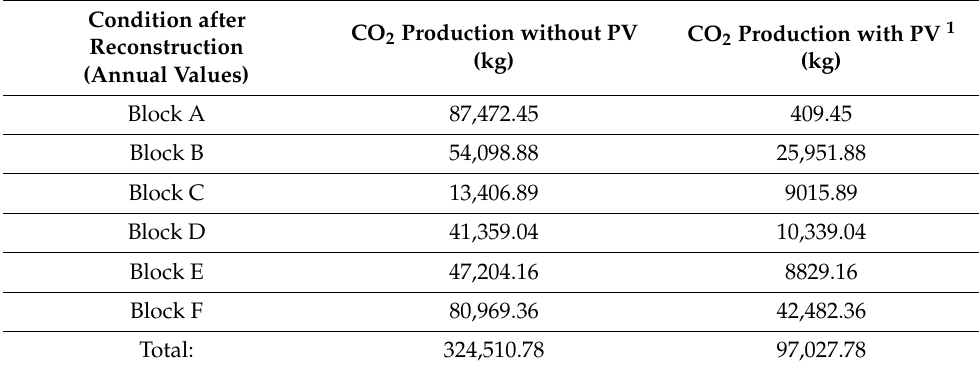
Table 6. CO 2 after reconstruction.